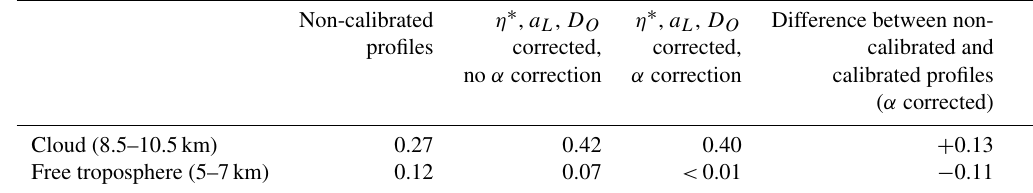
Figure 8. Data from 26 September 2013 at the RALI–Bucharest lidar system. (a) Range-corrected time series at 532nm; (b) volume linear depolarization ratios for noncorrected, ( η ∗ ,a L ,D O ) corrected and ( η ∗ ,a L ,D O ) and α ( Y ) corrected profile at 532nm with smoothed data, 45min time average and 45m vertical smoothing; (c) particle depolarization ratio profile at 532nm with smoothed data, 45min time average and 45m vertical smoothing. Table 3. Volume linear depolarization values of calibrated and non-calibrated retrievals for the RALI lidar system on 26 September